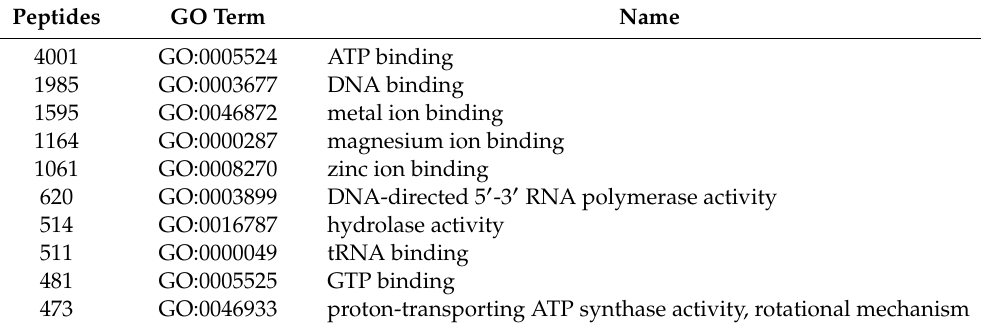
Table 1. The 10 most represented Gene Ontology (GO) molecular functions of the analyzed microbiome.